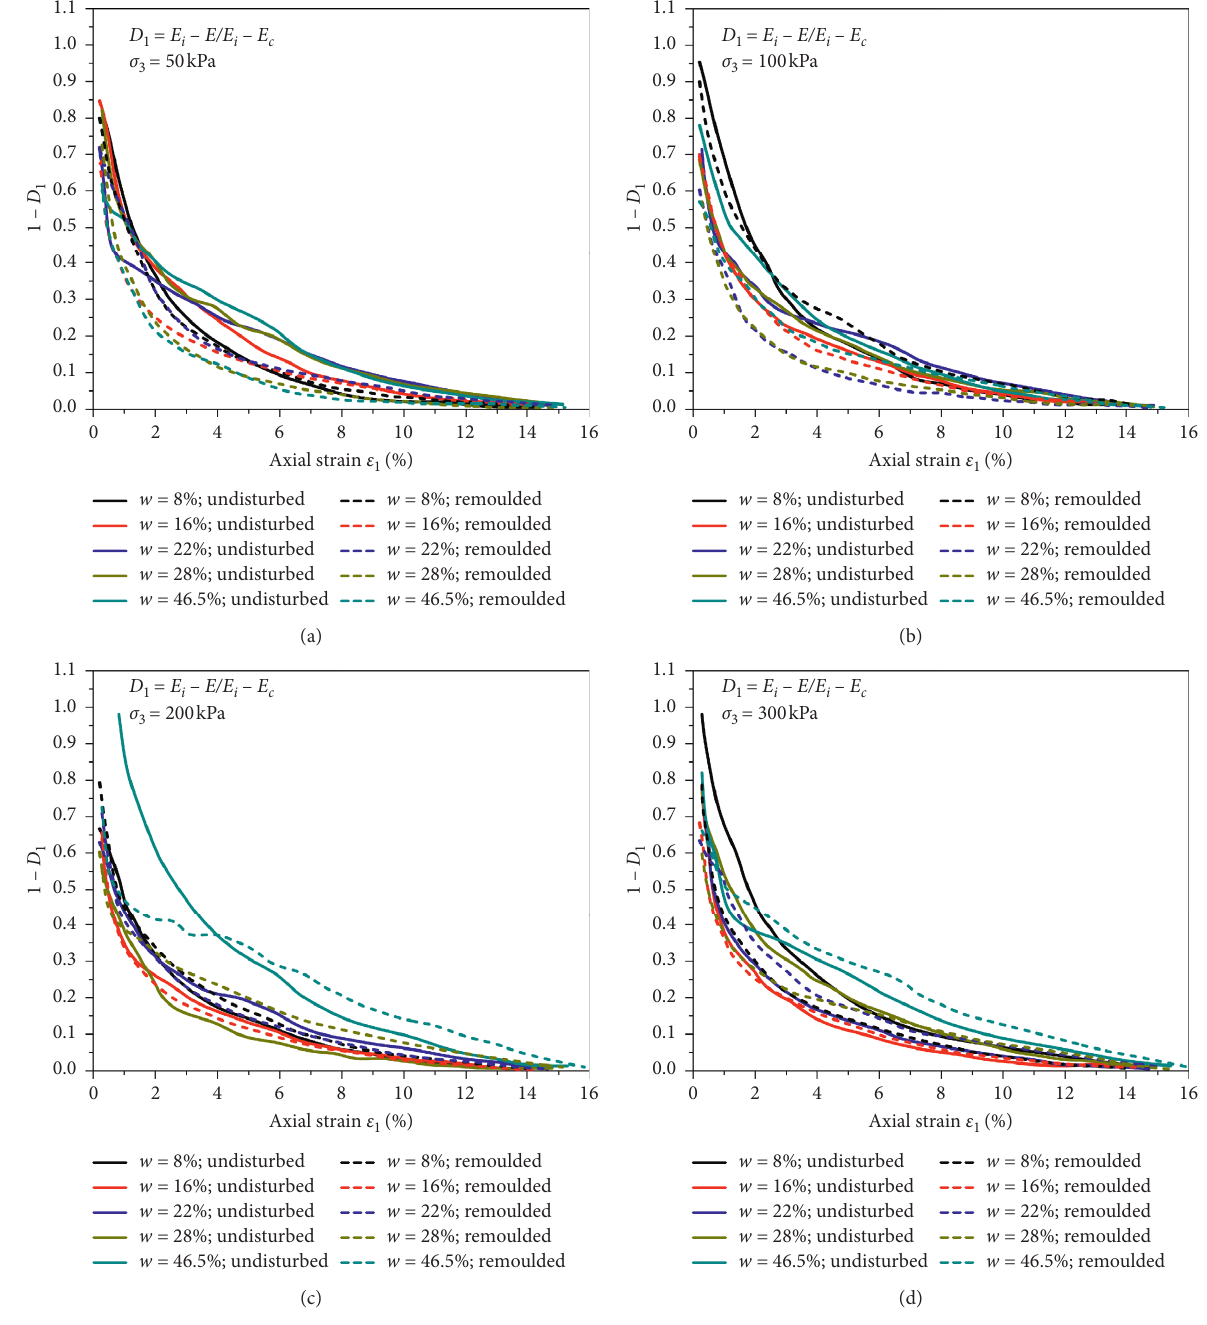
Figure 3: Evolution curves of single-parameter disturbance functions for undisturbed and remoulded soil samples. (a) σ